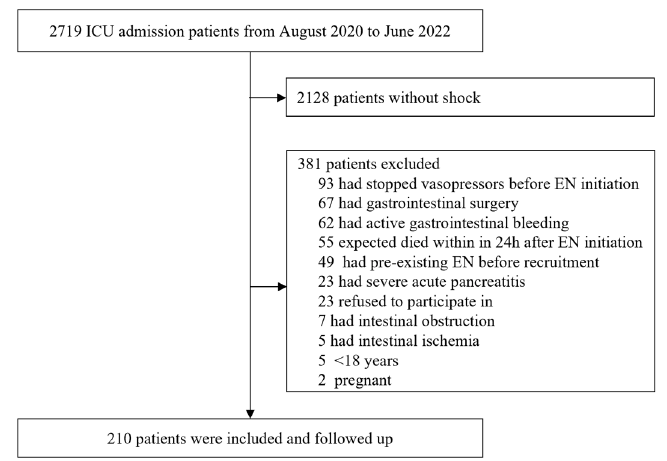
Figure 1. The enrollment and follow-up of patients. ICU, intensive care unit; EN, enteral nutrition.